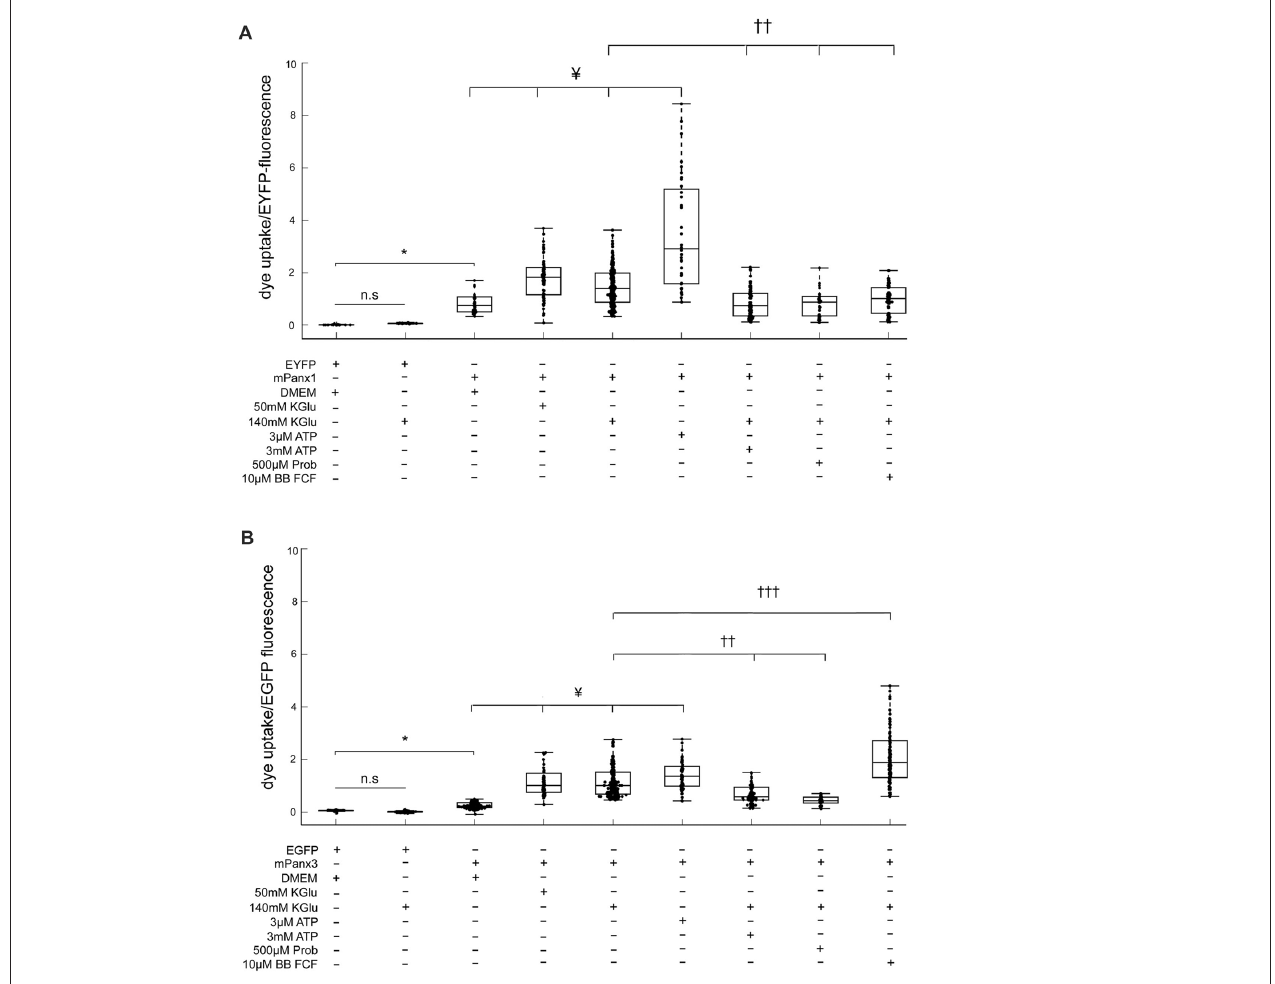
FIGURE 9 | Panx1 and Panx3 dye uptake properties. EtBr uptake assay is depicting the amount of dye taken up by Neuro2A cells that were transfected with EYFP, EGFP, mPanx1-EYFP or with mPanx3-EGFP. (A) Neuro2A-EYFP cells did not uptake dye, even when trying to stimulate with 140 mMKGlu. However, using either 50 mM KGlu, 140 mM KGlu, 3 µ M ATP on mPanx1 transfected cultures, significantly stimulated channel opening. 3 mM ATP, 500 µ M Prob or 10 µ M BB FCF application, after stimulation with 140 mM KGlu for 5 min, block the channel from taking up the dye. (B) EtBr uptake assay is depicting the amount of dye taken up by Neuro2A cells that were transfected with EGFP or with mPanx3. Neuro2A-EGFP cells did not uptake dye, even when trying to stimulate with 140 mMKGlu. However, using either 50 mM KGlu, 140 mM KGlu, 3 µ M ATP on mPanx3 transfected cultures, significantly stimulated channel opening. 3 mM ATP or 500 µ M Prob application, after stimulation with 140 mM KGlu for 5 min, block the channel from taking up the dye. Treatment with 10 µ M BB FCF after application of 140 mMKGlu enhanced dye uptake activity significantly compared to treatment with 140 mMKGlu alone. ∗ Indicate significance compared to Neuro2A controls, ∗ p < 0.0001. (cid:85) Indicate significance compared to basal conditions, (cid:85) p < 0.0001. †† Indicates significant decrease compared to 140 mM KGlu stimulation conditions, ††† indicates significant increase compared to 140 mM KGlu stimulation conditions †† p < 0.0001 and ††† p < 0.0001. KGlu (potassium gluconate), ATP (adenosine triphosphate), Prob (probenecid), BB FCF (Brilliant blue food